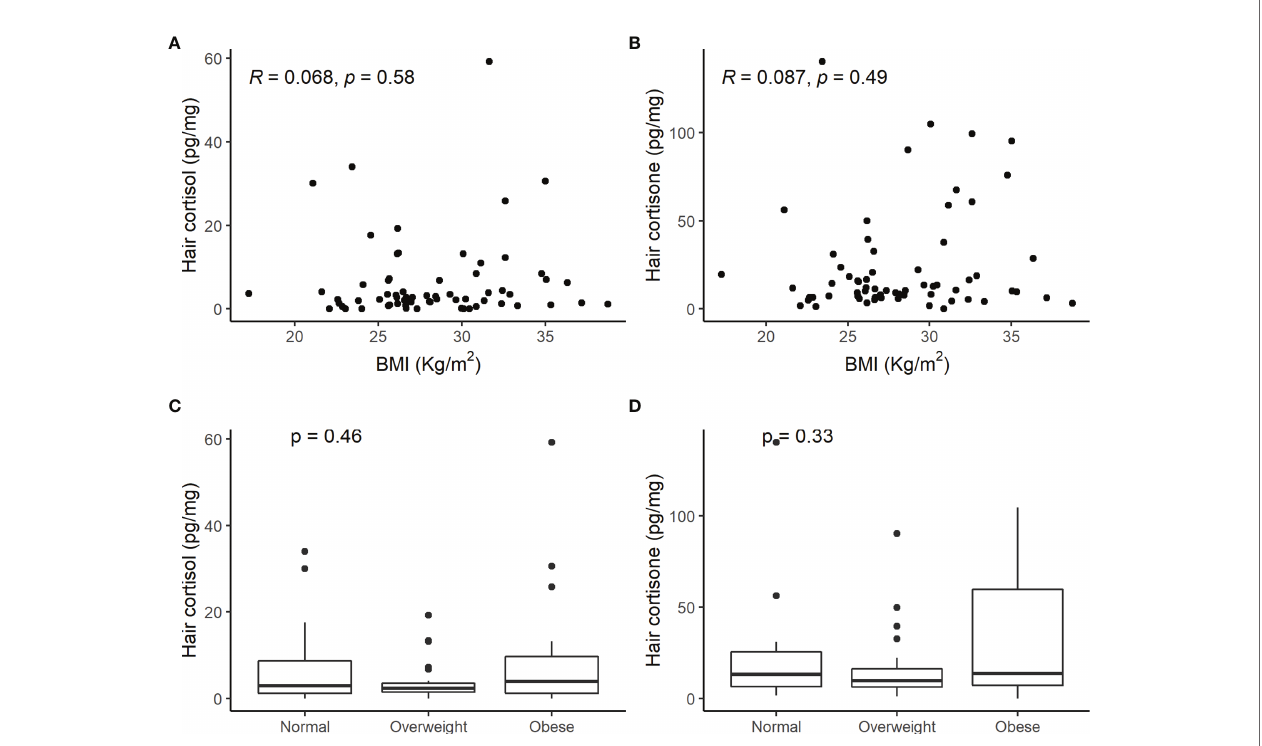
FIGURE 4 | Scatterplot of hair cortisol (A) and hair cortisone (B) levels and body mass index (BMI) and comparison of hair cortisol (C) and cortisone (D) concentrations in normal weight, overweight, or obese patients with adrenal incidentaloma. No signi fi cant correlation between hair steroids and weight was